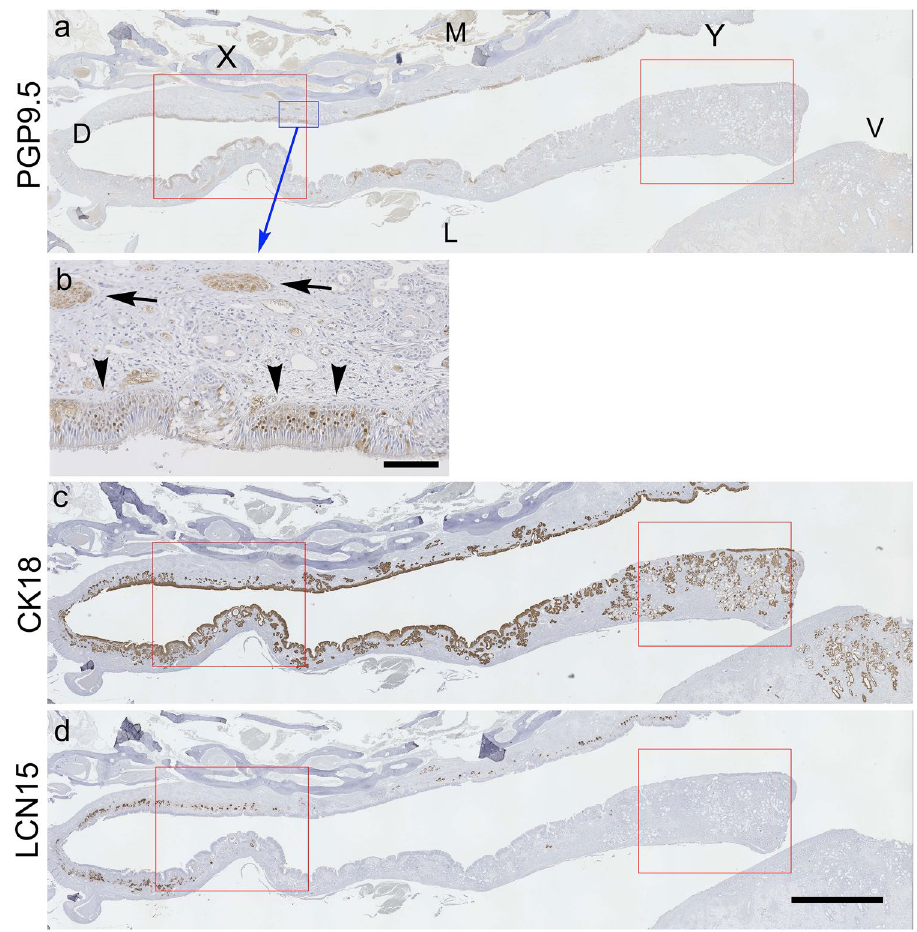
Figure 2. Immunohistochemical staining of human olfactory cleft mucosa sections with rabbit anti-PGP9.5 antibody ( a and b ), rabbit anti-cytokeratin 18 antibody ( c ), and rabbit anti-LCN15 antibody ( d ). A, C, D: D, V, M, and L in A indicate dorsal, ventral, medial, and lateral zones of the nasal cavity, respectively. Left and right sides of the image correspond to superior and inferior ends of the olfactory cleft. Red rectangles (X and Y) indicate microscopic fields, shown as a magnified view in Supplementary Fig. 3. ( a ): PGP9.5 immunoreactivity is observed in sparse island areas of the olfactory mucosa area. ( b ): Magnified view of the field indicated by the blue rectangle in a . PGP9.5-positive ORNs are observed in the epithelium (black arrowheads). In the lamina propria, PGP9.5-positive olfactory nerve bundles are shown by the black arrows. ( c ): CK18 immunoreactivity in the epithelium and submucosal glands of the olfactory cleft mucosa. ( d ): LCN15 immunoreactivity in the submucosal glands, mainly in the superior end of the cleft. Scale bar in b = 100 μm and in d (also applies for a and c ) = 2